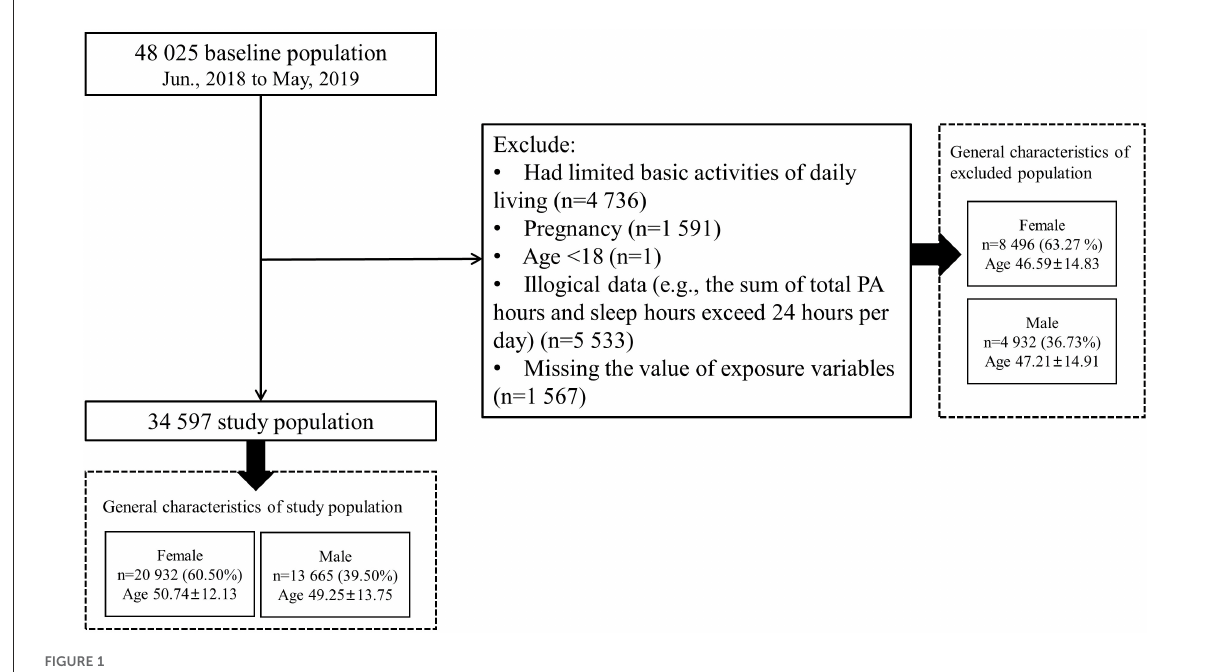
FIGURE1 Flow diagram of the study population.